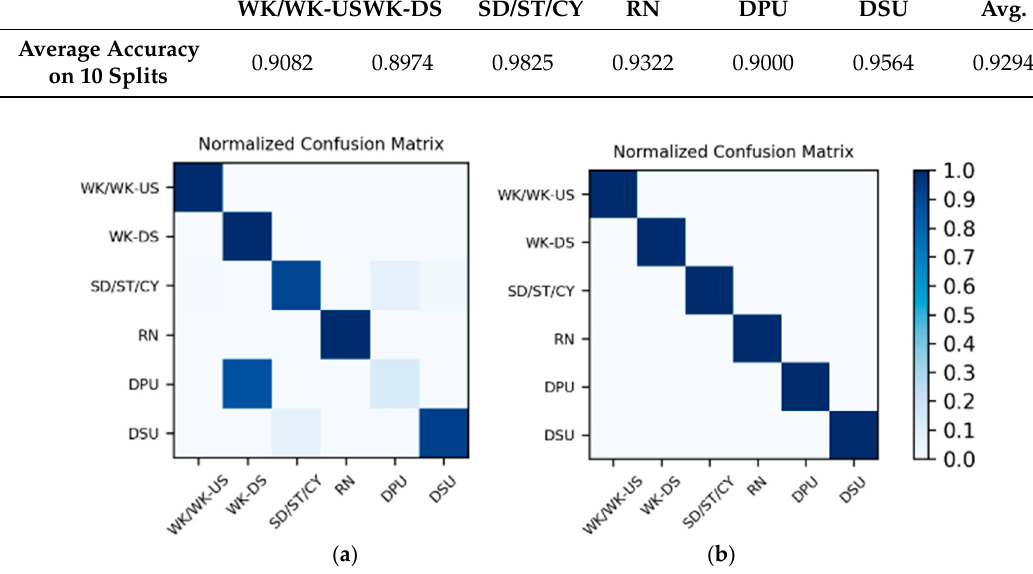
Figure 20. Confusion matrices for the two splits with ( a ) the lowest accuracy and ( b ) the highest accuracy on motion sensor data in the Multimodal Dataset. accuracy on motion sensor data in the Multimodal